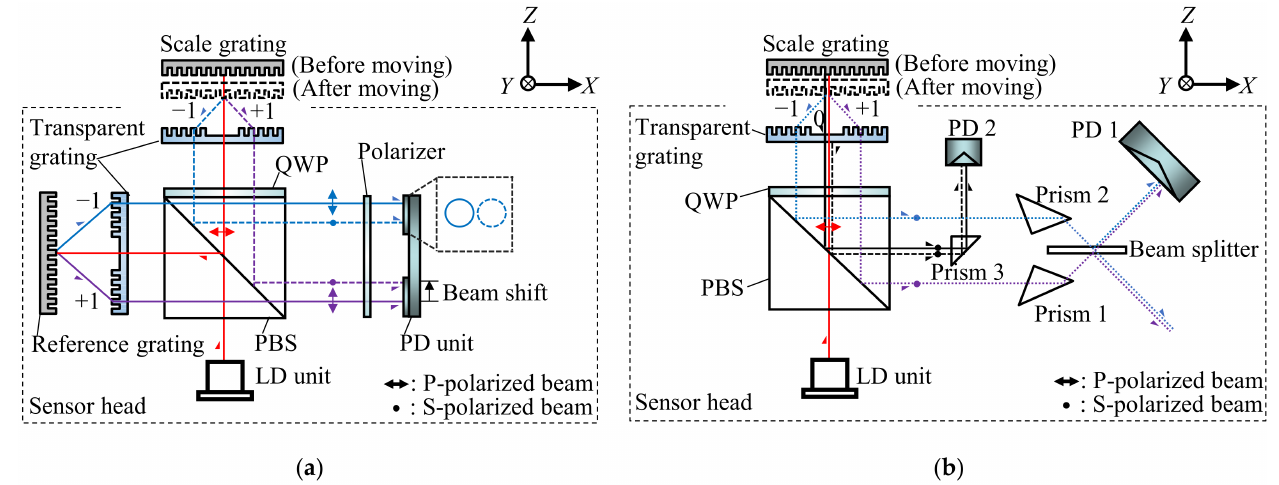
Figure 4. Optical configurations of the conventional surface encoder and the newly proposed surface encoder: ( a ) A schematic of the conventional surface encoder; ( b ) A schematic of the newly proposed surface encoder.